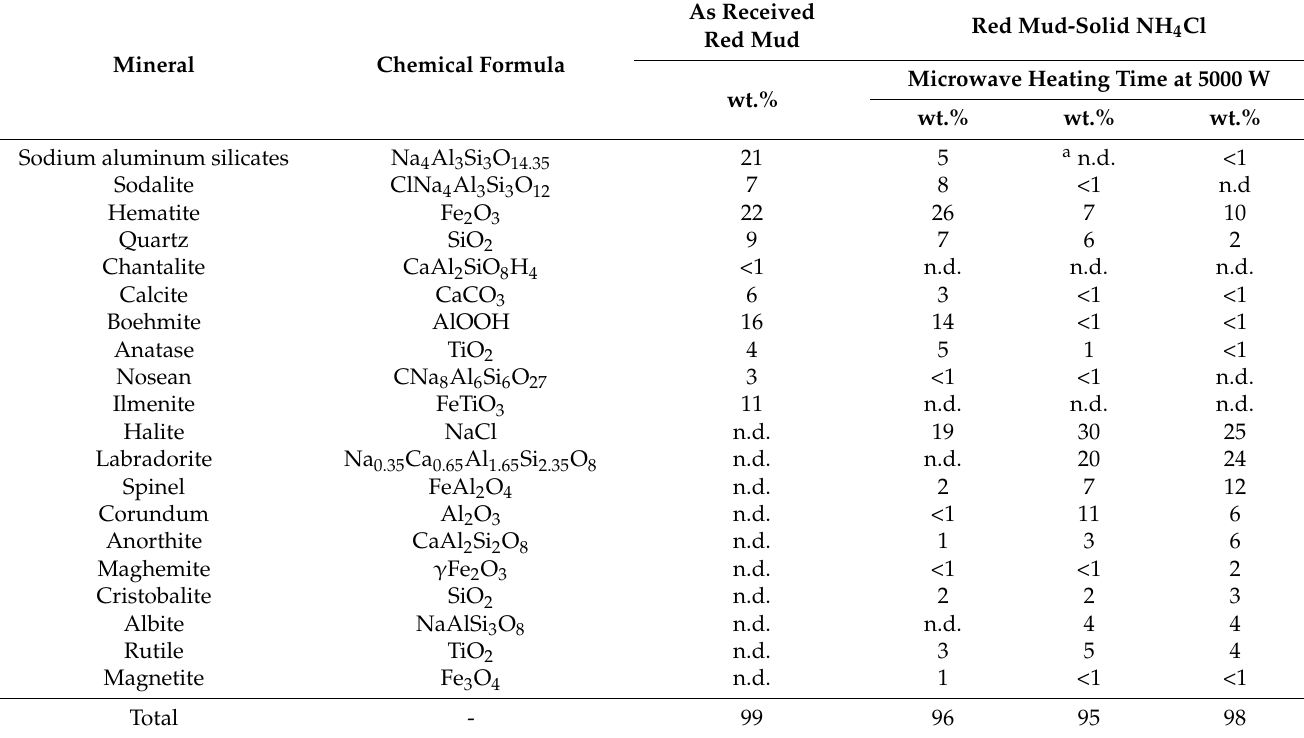
Table 4. Semi-quantitative mineralogical analysis results using the Rietveld method of microwave-heated red mud-solid NH 4 Cl at 5000